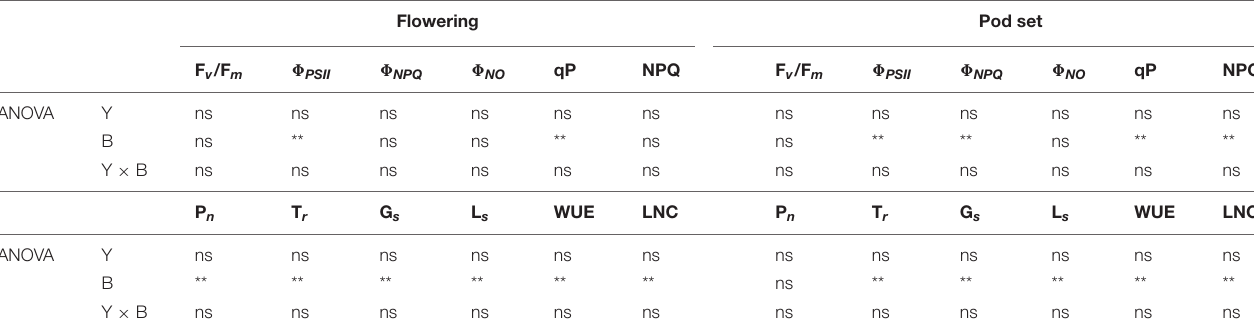
TABLE 1 | Leaf chlorophyll fluorescence parameters and gas exchange parameters at the flowering and pod set in peanut with four rates of biochar in the 2018 and 2019 growing seasons.